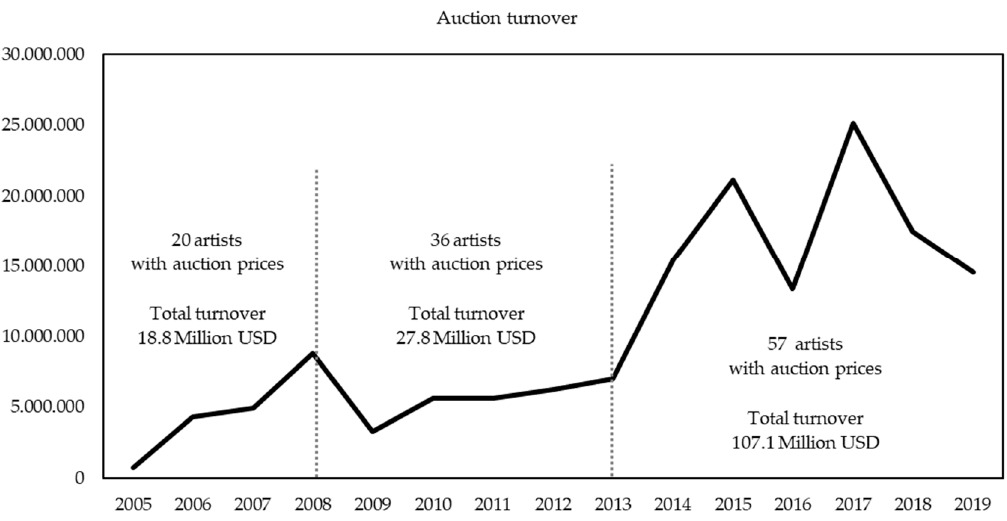
Figure 5. Auction turnover of selected Art Basel artists.